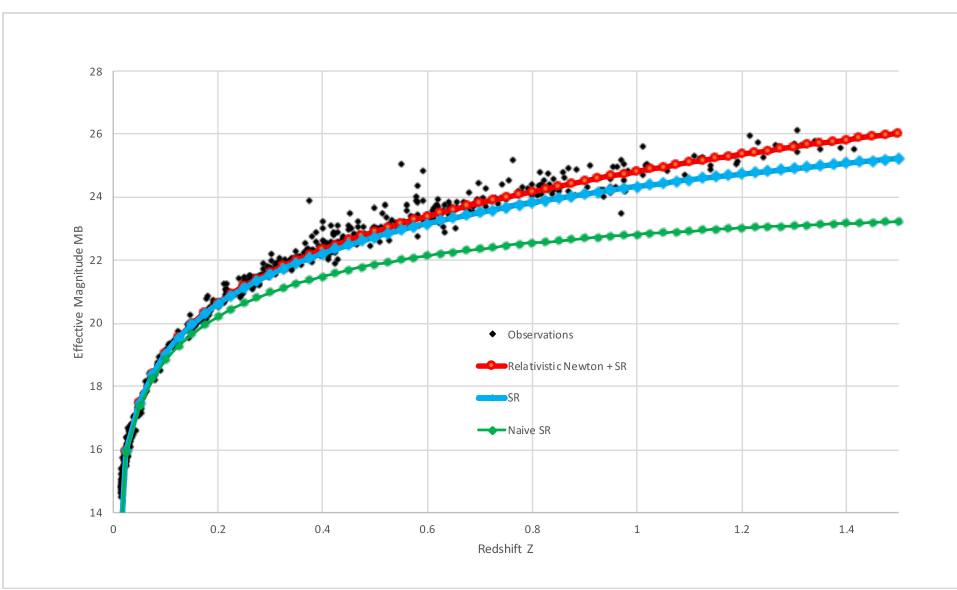
Figure 2. The figure shows 580 supernova data points from the Union-2 database in black. The red line represents the predictions from our relativistic Newton gravity, the blue line is predictions from SR only, and the green line is what we call the naive SR model, where we do not take into account that the supernova is moving during the time it takes for the light to move from the supernova to the